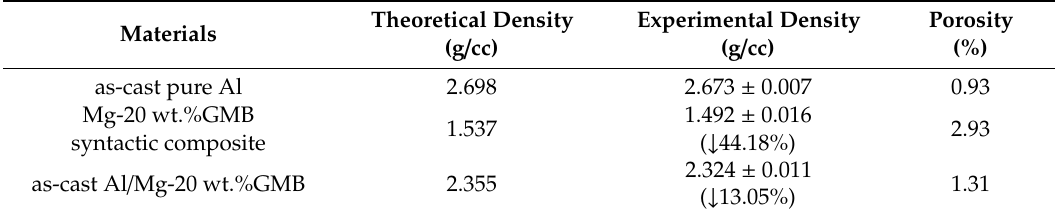
Table 1. Density and porosity of as-cast pure Al, Mg-20GMB syntactic composite core, and as-cast Al / Mg-20GMB hybrid